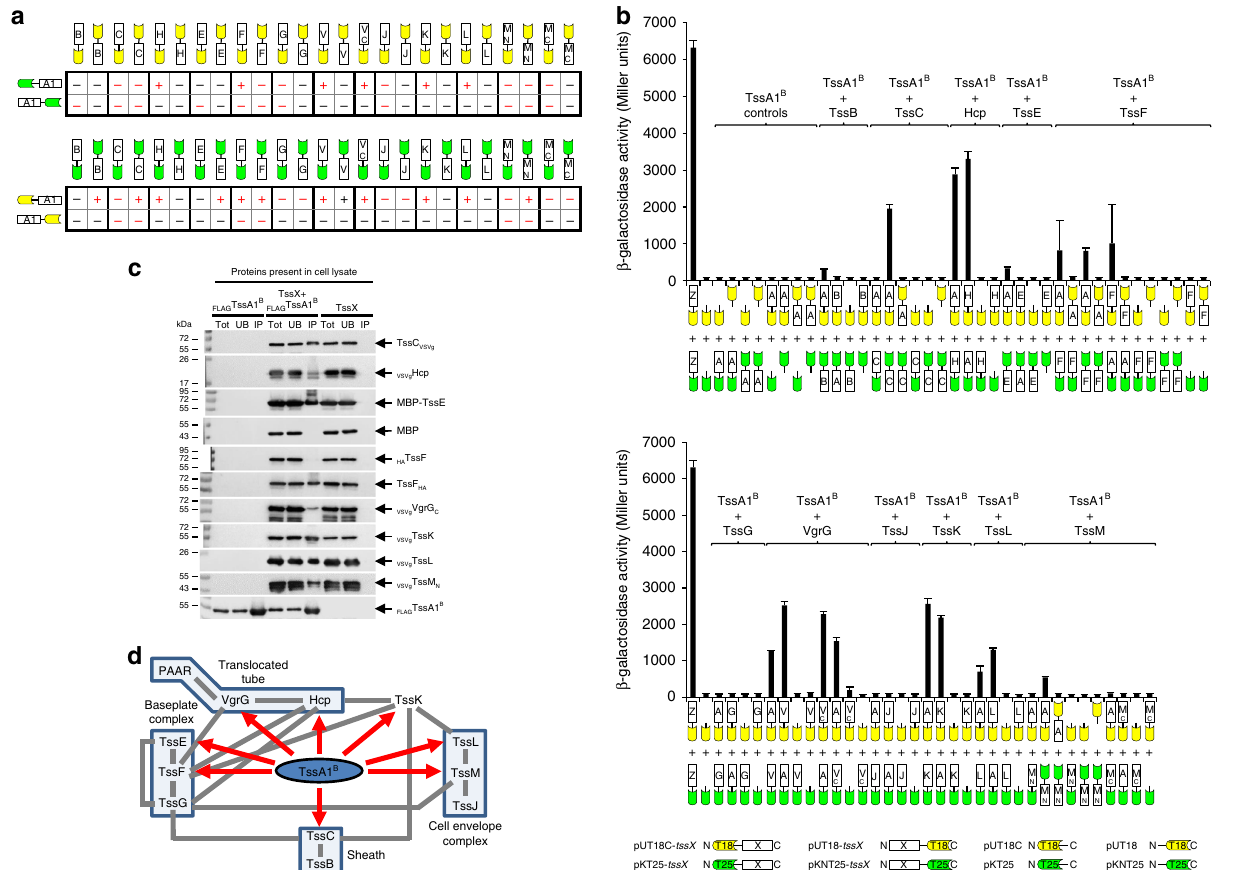
Fig. 2 Interaction of TssA1 B with other T6SS subunits. a Two-hybrid analysis (maltose phenotypes). Hybrid proteins are represented by a green or yellow coloured motif representing the CyaA fragment (T25 and T18, respectively) linked to a white rectangle labelled according to the fused T6SS subunit, as shown in the key at the bottom of ( b ). T6SS subunits are indicated by a single letter corresponding to the suf fi x used in the Tss nomenclature (i.e. A1 corresponds to TssA1 B , B corresponds to TssB etc) except for H (Hcp), V (VgrG) and V C (VgrG core region). M N and M C represent the N-terminal cytoplasmic and C-terminal periplasmic regions of TssM, respectively. The ef fi ciency of complementation of representative combinations (phenotypes shown in red font) were determined by β -galactosidase assay. b Two-hybrid analysis ( β -galactosidase activity). Data is representative of three independent experiments ( n = 3) performed in duplicate and values correspond to the mean ± standard deviation. Nomenclature as in ( a ). Z represents the Zip